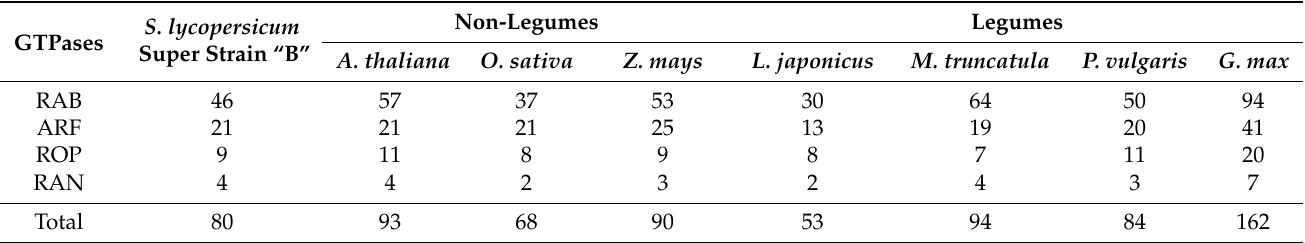
Table 1. Number of each small GTPases subfamily members expressed in Solanum lycopersicum super strain “B” compared with some non-leguminous and leguminous plants retrieved from the data base.